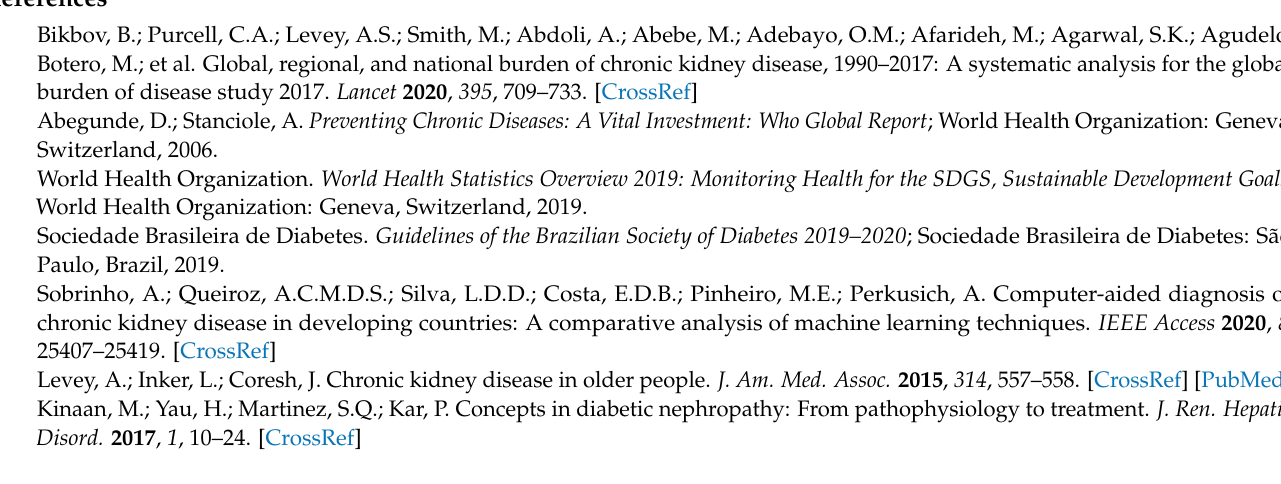
Table S3: Results for the multiple stratified CV method without using the framework proposed by Pineda-Bautista et al. [23], Table S4: Results for the nested CV method without using the framework proposed by Pineda-Bautista et al. [23], Figure S1: PRC curves for the DT model using SMOTE and the nested CV method for the four first folds, Figure S2: PRC curves for the DT model using SMOTE and the nested CV method for the fifth, sixth, seventh, and eighth folds, Figure S3: PRC curves for the DT model using SMOTE and the nested CV method for the ninth and tenth